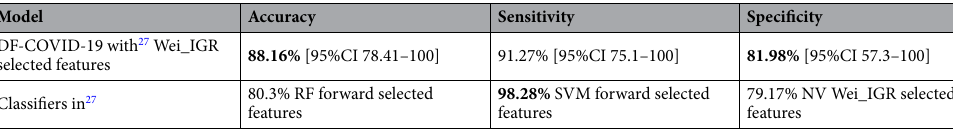
Table 3. The comparison results between DF-COVID-19 and other classifiers.